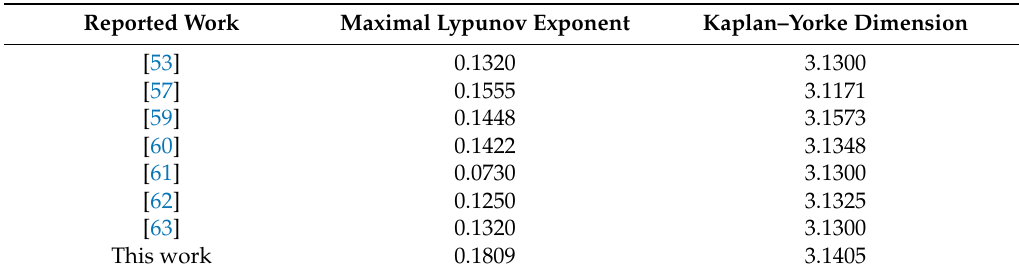
Table 1. Comparison of system (8) with other reported hyperchaotic hyperjerk systems regarding the maximal Lyapunov exponent and the Kaplan–Yorke